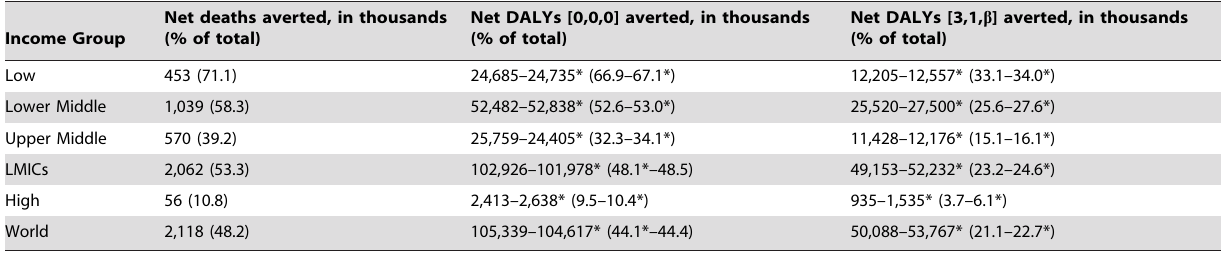
Table 2. Net deaths and DALYs averted by income group.